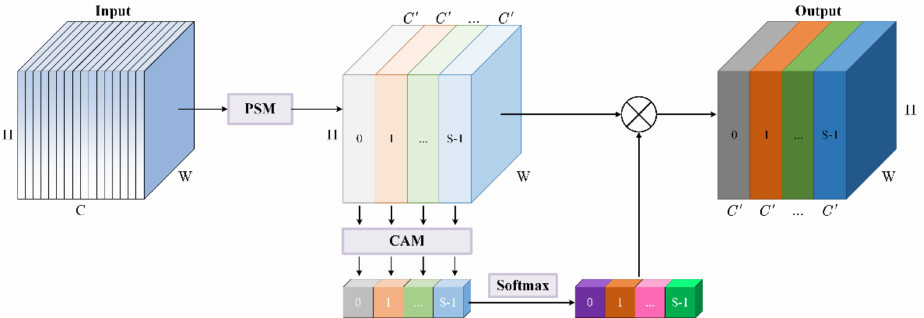
Figure 4. The structure of the proposed Pyramid Cross Channel Attention module (PCCA).